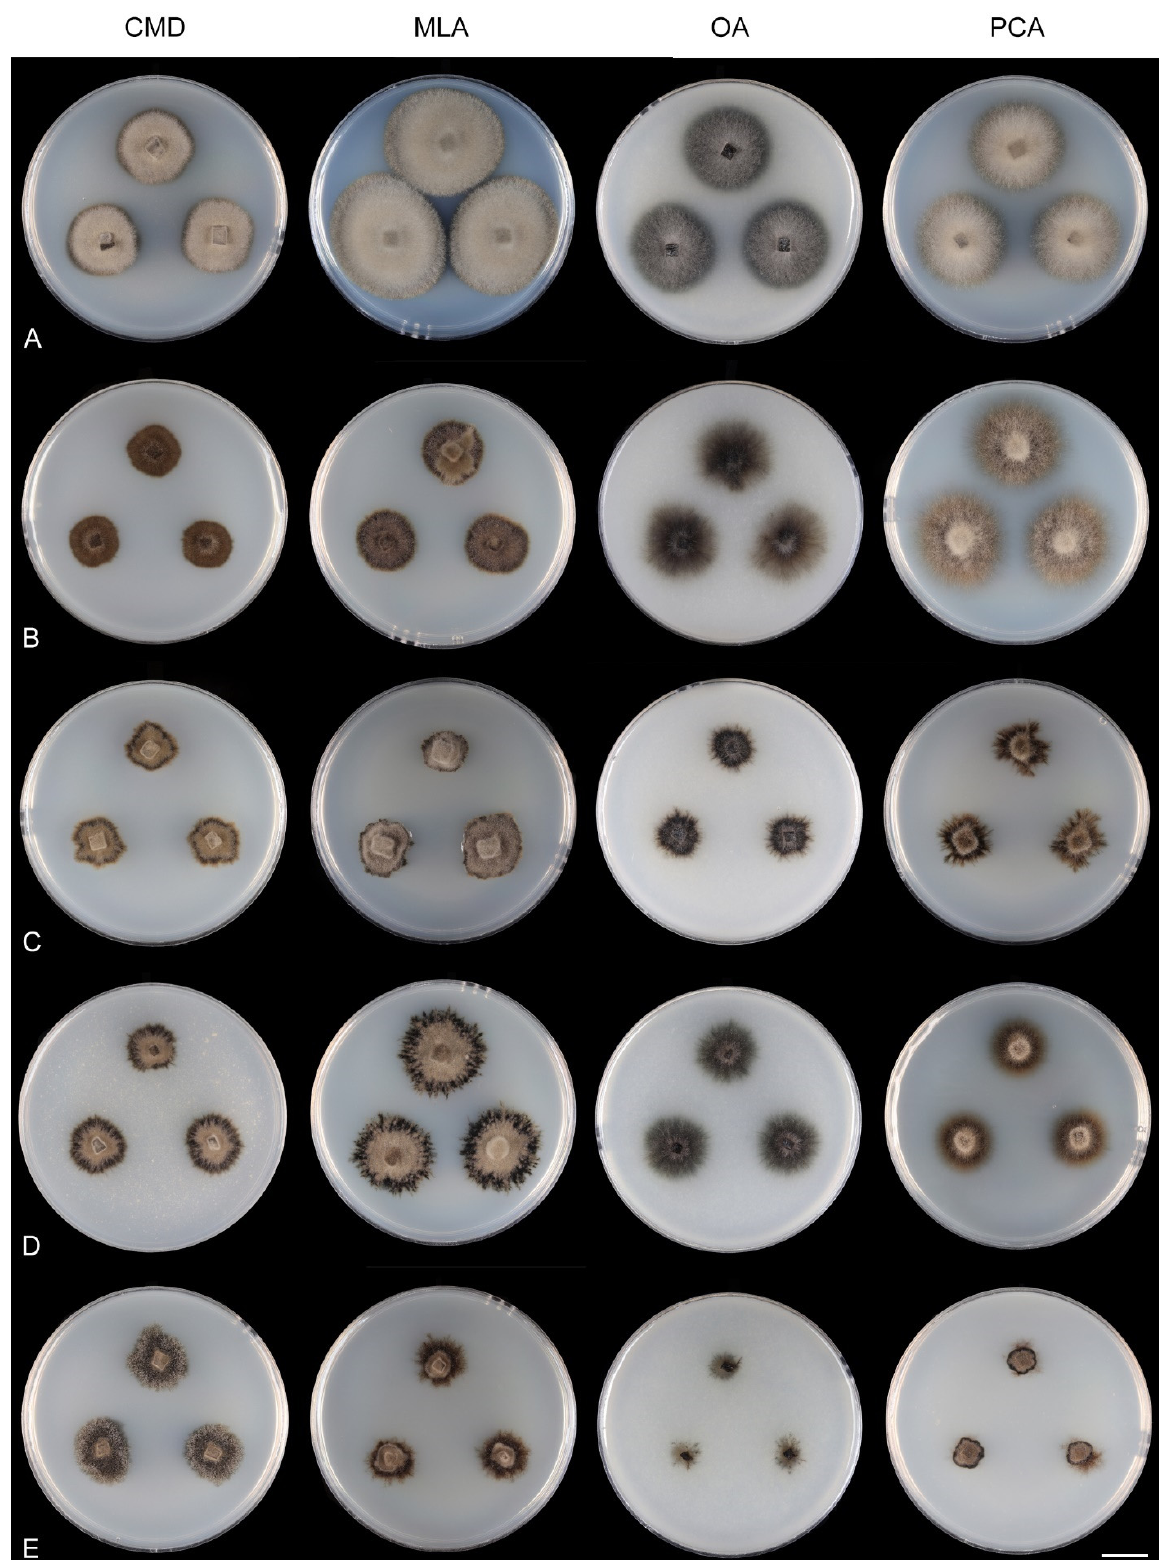
Figure 8. Colony morphology of Zanclospora novae-zelandiae species complex on cornmeal dextrose agar (CMD), Modified Leonian’s agar (MLA), oatmeal agar (OA) and potato-carrot agar (PCA) after 4 weeks. ( A ) Z. clavulata CBS 146967. ( B ) Z. falcata ICMP 23702. ( C ) Z. iberica CBS 130426. ( D ) Z. iberica CBS 130280. ( E ) Z. novae-zelandiae ICMP 15781. Bar: ( A – E ) = 1 cm.